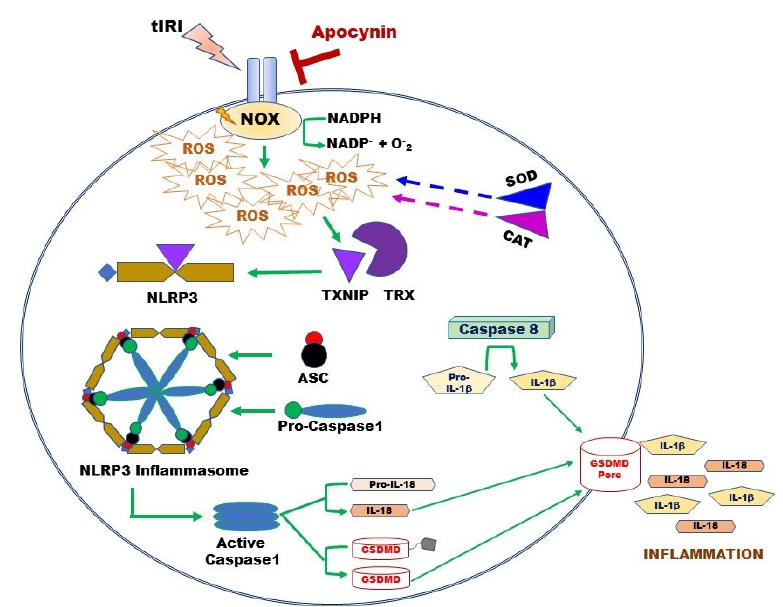
Figure 6. Overview of the activation mechanism of the NLRP3 Inflammasome Pathway during tIRI. Following tIRI, activated NOX sequesters cellular NADPH to produce ROS and thus, weakening the antioxidant enzymes SOD and CAT. ROS accumulation causes TXNIP to dissociate from TRX and binds to NLRP3 protein. Active NLRP3 assembles with ASC and pro-caspase-1 to form the inflammasome. Released caspase-1 will activate IL-18 and GSDMD. Independently, caspase 8 will trigger IL-1 β production. GSDMD penetrates the cell membrane, forming non-selective pores to release IL-1 β and IL-18 and triggering tissue inflammation. Pore formation results in rapid loss of membrane integrity and lytic cell death.